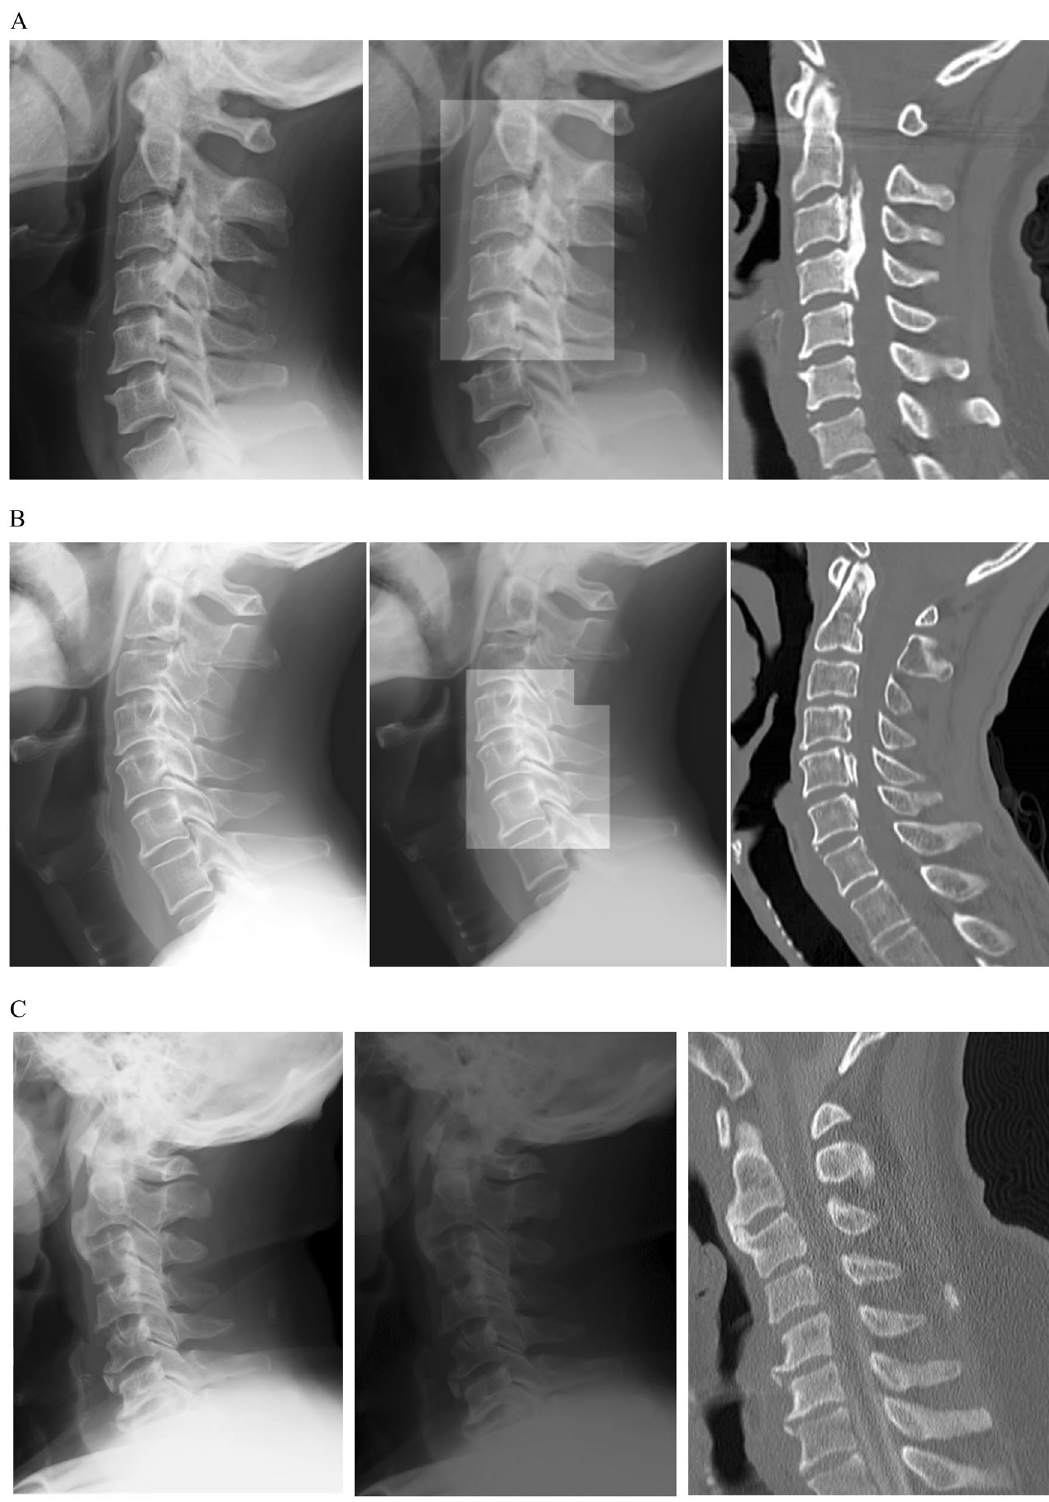
Figure 2. Representative images used and created by the deep learning algorithm are shown. The left image shows the cervical plain radiograph used in the deep learning algorithm. Images created by our algorithm are shown on the center. The right image shows a sagittal slice of the computed tomography image used as the ground truth, but not used in the algorithm. The algorithm was designed to highlight areas of suspected ossification of the posterior longitudinal ligament (OPLL) when OPLL was identified in an image. ( A ) An image from a 47-year-old women with a continuous-type OPLL from C2–C4 is shown. ( B ) An image from a 56-year- old man with a small segmental OPLL at C5 and C6 is shown. ( C ) An image from a 63-year-old man without cervical OPLL is